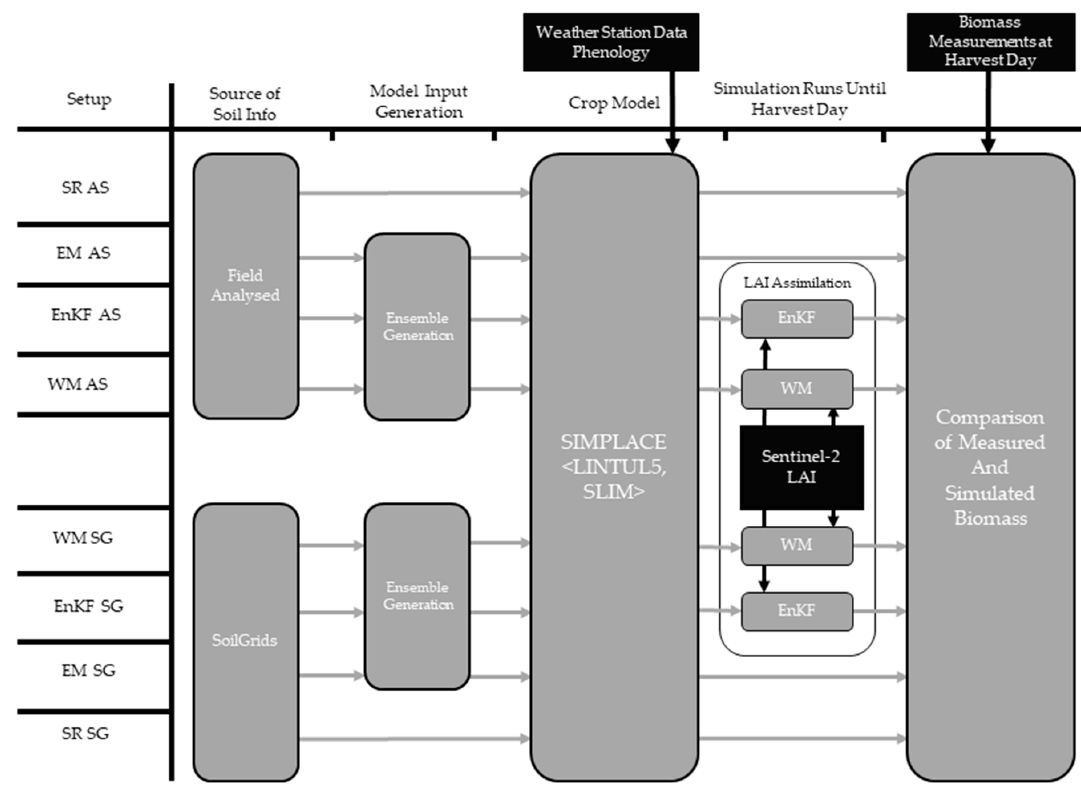
Figure 2. Workflow for the range of setups investigated in this study. Every setup was run for every sampling point in every field that was part of this study. SR: standard run, EM: ensemble mean, EnKF: ensemble Kalman filter, WM: weighted mean, AS: analyzed soil texture, SG: SoilGrids-derived soil texture.